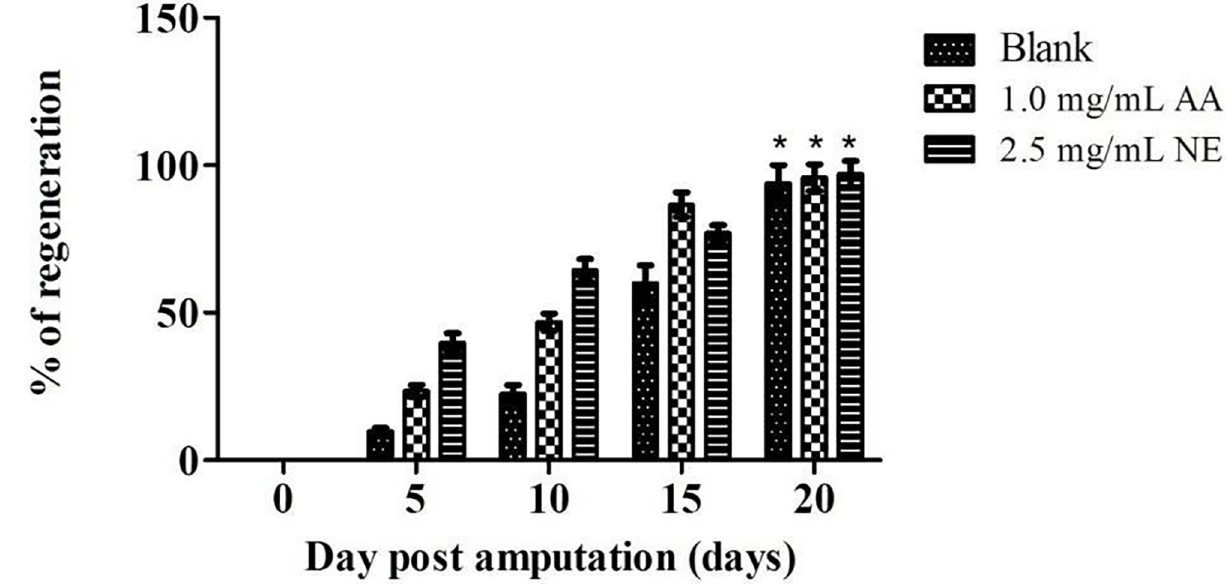
Fig 8. The effect of treatments on zebrafish tails regeneration (n = 10). Notes: Blank = untreated samples; AA = Ascorbic acid; NE = Nanoemulsions; � means no significant difference from each other.